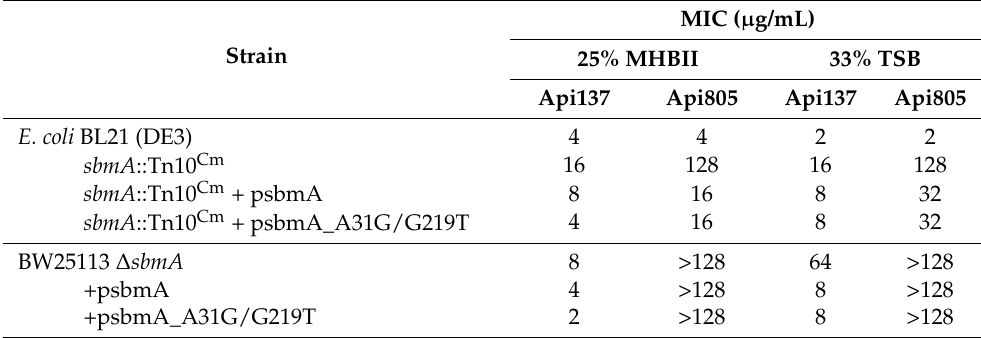
Table 3. MIC values obtained for Api137 and Api805 against transposon-mutated E. coli